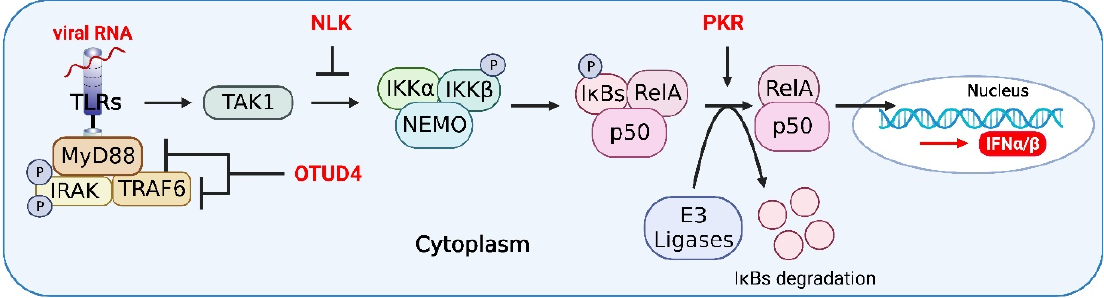
Figure 4. Host proteins in the crosstalk of IFN, NF- κ B, and inflammasome signaling pathways. OTUD4 antagonizes the recruitment of MyD88 to TRAF6, which inhibits the activation of the NF- κ B signaling pathway by inhibiting the K63-linked ubiquitination of TRAF6, thereby relieving inflammatory responses in host cells. NEMO-like kinase (NLK) regulates NF- κ B signaling by disrupting the interaction between TAK1 and IKK. PKR leads to a significant reduction in host cell translation and I κ B degradation, which induces activation of the NF- κ B signaling pathway. The figure was created using the online software “Biorender” (https://app.biorender.com/ The updated figure was created on 30 November 2022).